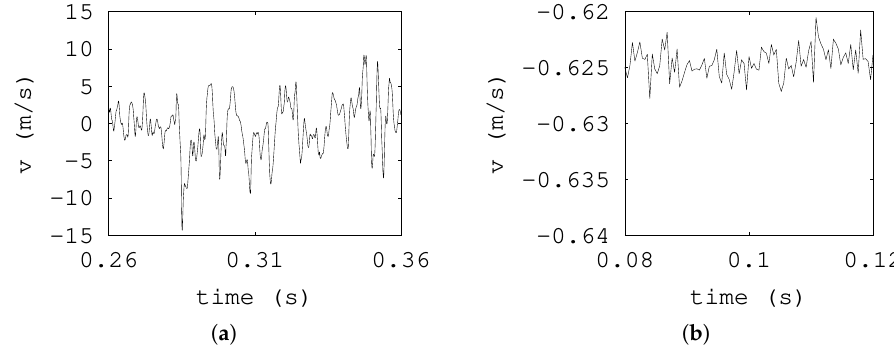
Figure 9. Time trace of the vertical velocity in the nonreacting incompressible simulations ( a ) and reacting incompressible simulations ( b